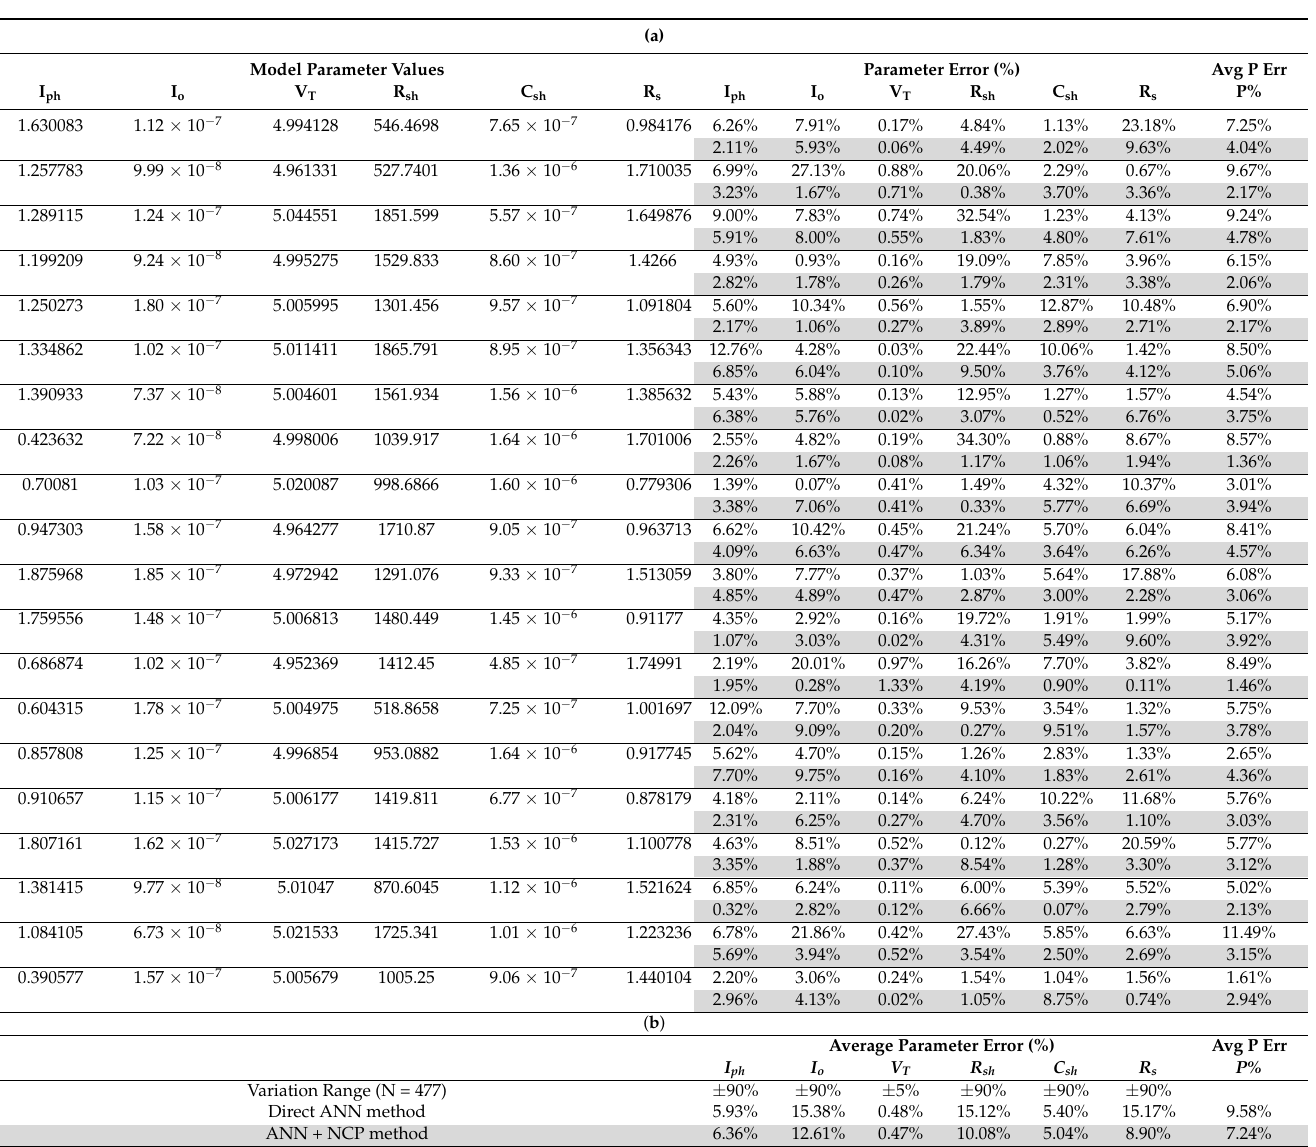
Table 3. ANN + NCP (Input 100, V[0] . . . V[49], i[0] . . . i[49], three hidden layers, 1st hidden layer 200 nodes, 2nd hidden layer 150 nodes, 3rd hidden layer 50, output 6 model parameters values, learn- ing rate 0.1, NPC learning rate 0.01. (N = 3693, Training data 2951, Testing data 739). ( a ) Estimation error of the model parameters (20 data samples), Direct ANN method, and ANN + NCP method (grey). ( b ) Summary of average estimation error of the model parameters for testing dataset, direct ANN method, and ANN+NCP method